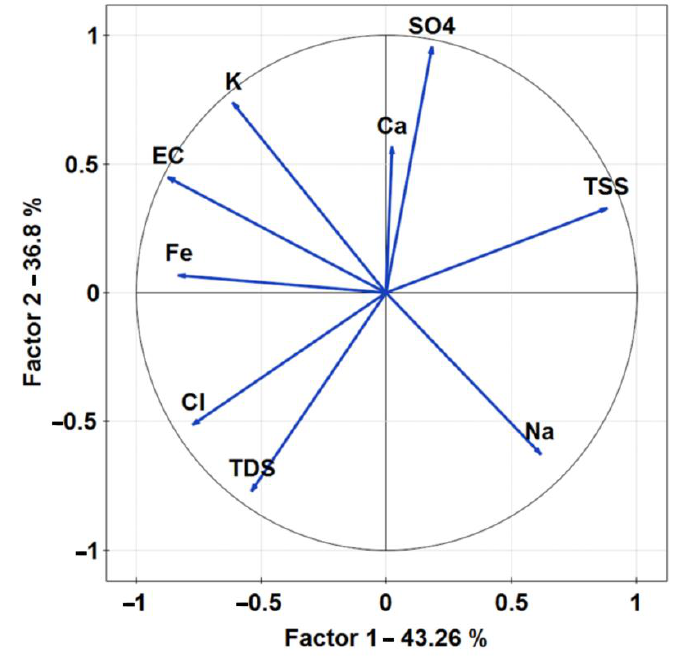
Figure 13. Projected data for physicochemical properties of stream in studied suburban area using PCA.